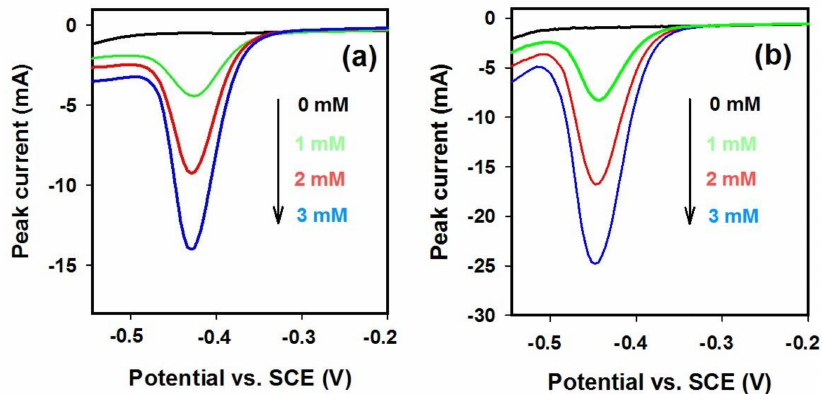
Figure 7. Linear sweep voltammetry (LSV) curves recorded in solutions containing 0.1 M Na 2 SO 4 and nitrate of different concentrations (pH = 2) at two physically stable electrodes: ( a ) SNWE-1 prepared at 600 ◦ C and ( b ) SNWE-2 prepared at 400 ◦ C. The scan rate is 40 mV s − 1